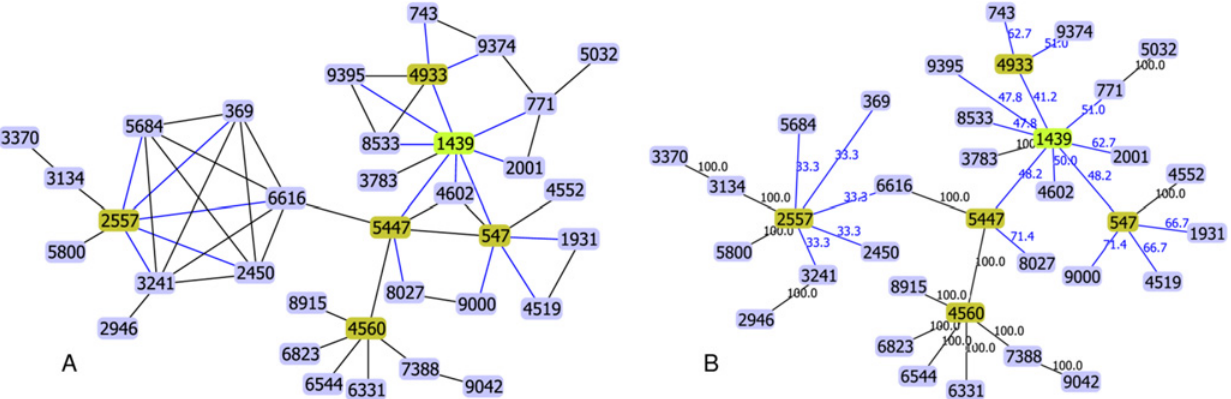
Fig 1. Representation of S. pneumoniae CC1439 using PHYLOViZ. A) Representation of all edges linking STs at SLV level. B) Representation of edges from the MST selected after application of the goeBURST rules, with the spanning edge betweenness for each edge.